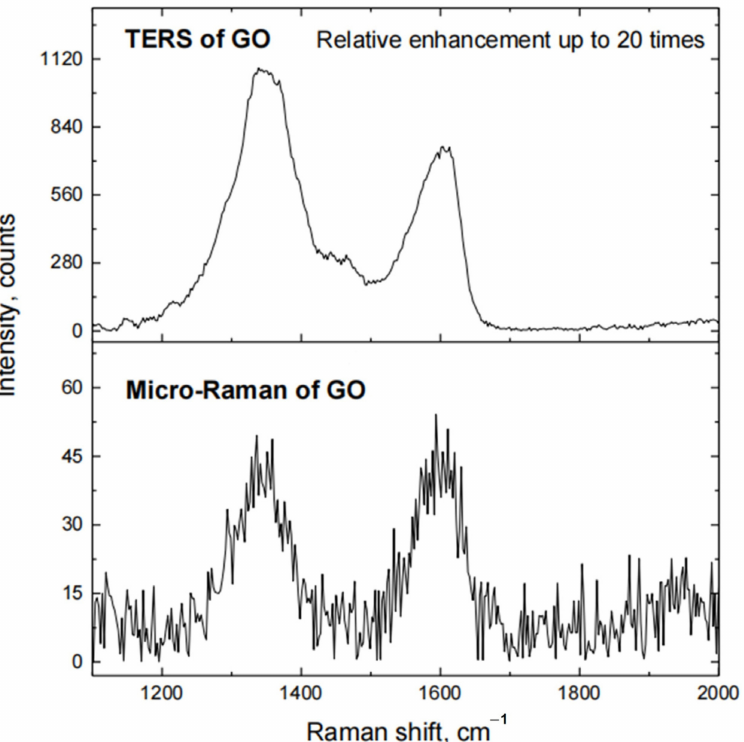
Figure 3. Raman spectra of GO, when Si tip coated with electroless Au (deposition time 1 min) is in contact with the surface of Si substrate, coated with a film of GO (TERS of GO), and when this tip is retracted from the surface of the substrate (Micro-Raman of